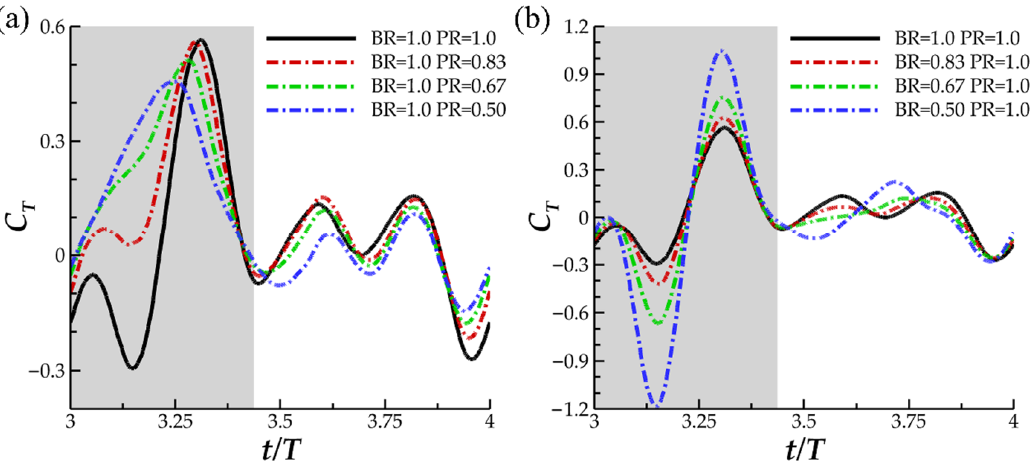
Figure 6. Instantaneous C T for ( a ) the baseline case (BR = 1.0 PR = 1.0), case 1 (BR = 1.0 PR = 0.83), case 2 (BR = 1.0 PR = 0.67) and case 3 (BR = 1.0 PR = 0.50); ( b ) the baseline case (BR = 1.0 PR = 1.0), case 4 (BR = 0.80 PR = 1.0), case 2 (BR = 0.67 PR = 1.0) and case 3 (BR = 0.50 PR = 1.0).